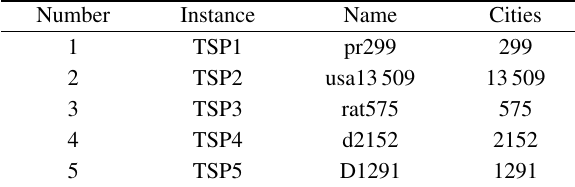
Table 6 Traveling salesman problem